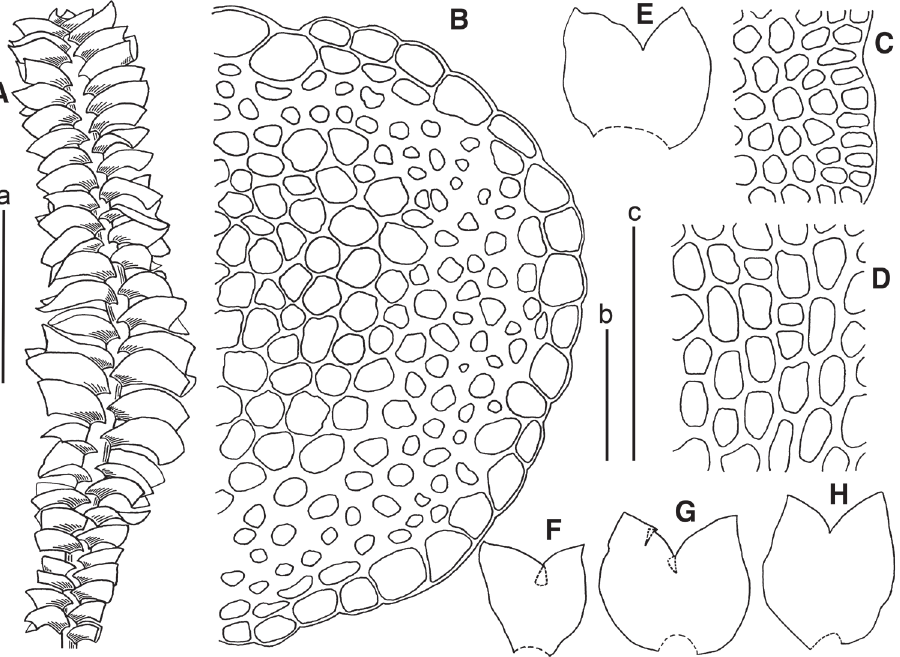
Figure 8. Marsupella yakushimensis (Horik.) S.Hatt. A plant, dorsal view B stem cross section (fragment) C cells along leaf margin D midleaf cells E–H leaves. Scale bars: a 2 mm ( A ); b 1 mm ( E–H ); c 100 μm ( B–D ). All from Choi-1067